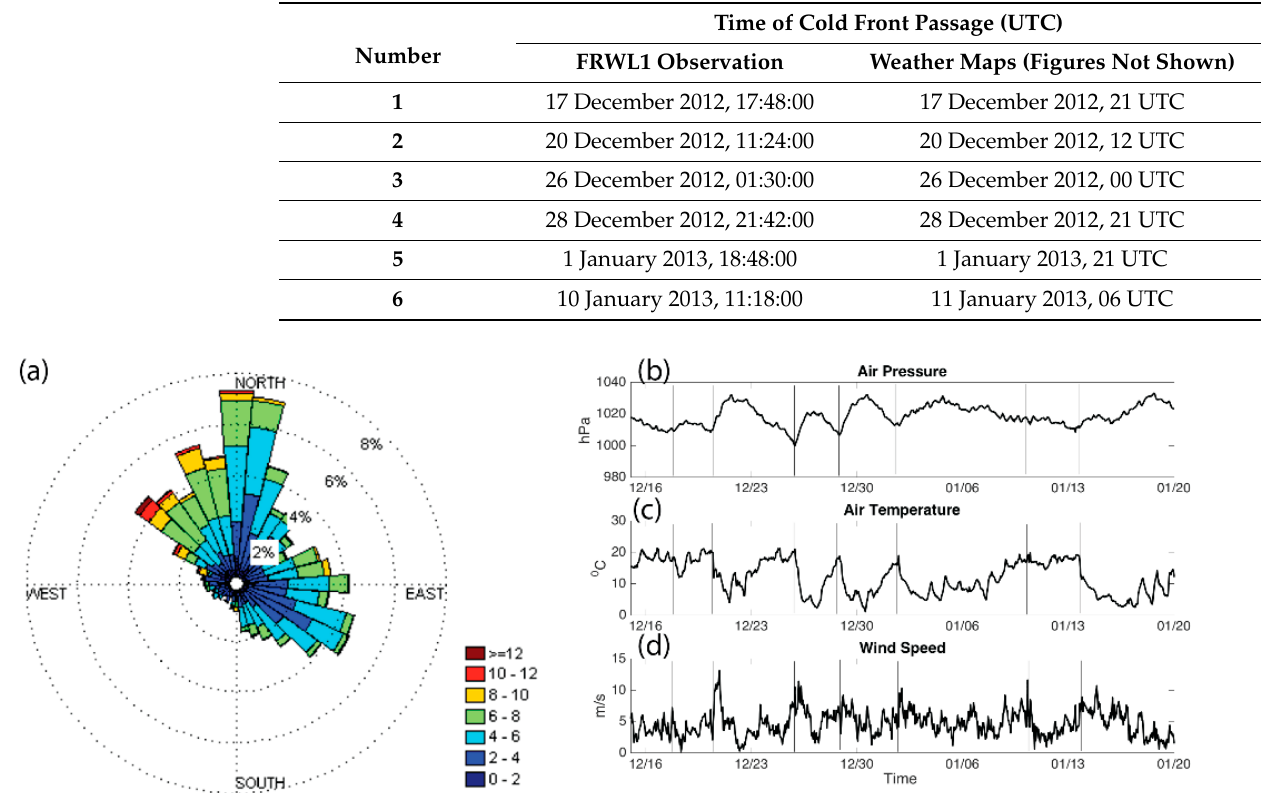
Table 4. Summary of cold fronts between 15 December 2012and 13 January 2013identified from meteorological observations at FRWL1 and weather maps, respectively.